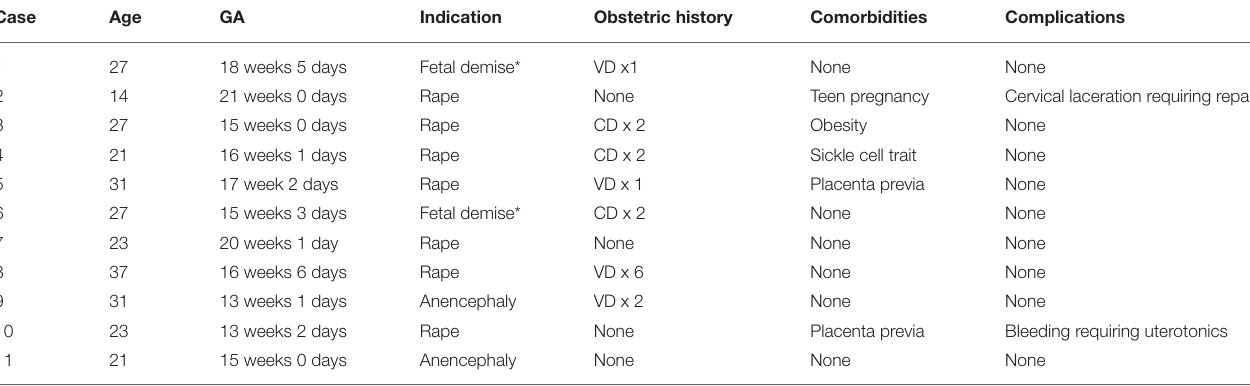
TABLE 1 | Clinical characteristics of D&E cases performed during focused clinical training period at Hospital Maternidade Vila Nova Cachoeirinha, São Paulo. Case